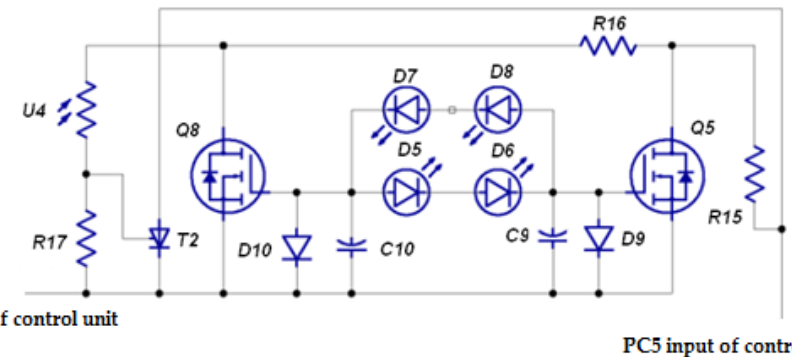
Figure 8. Wiring diagram of the solar radiation detection system for the sensor-based control of the change in the spatial